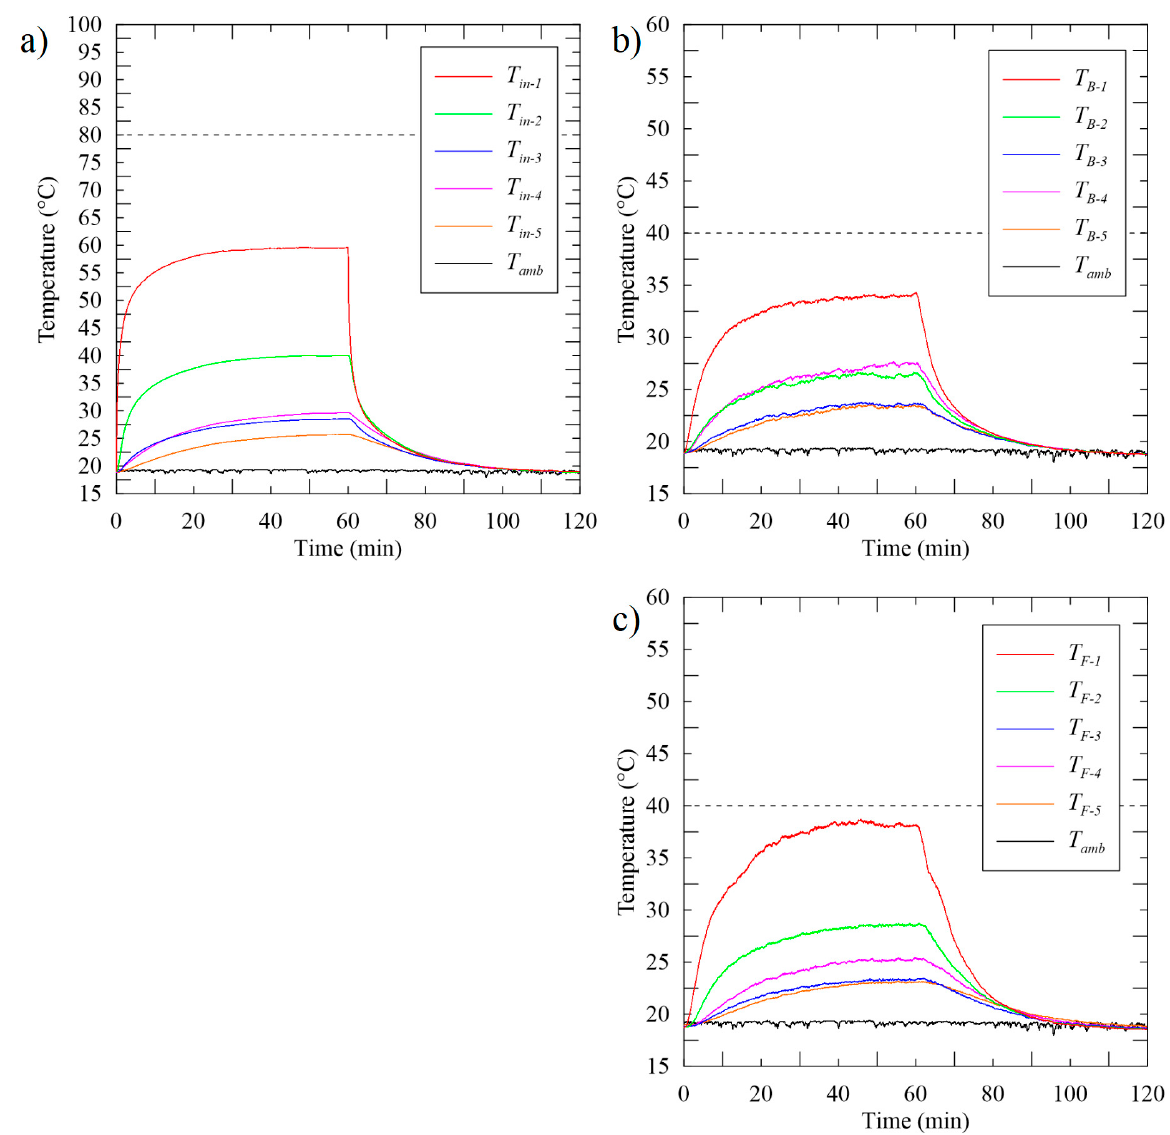
Figure 8. Temperature measurements on the ( a ) inside, ( b ) back cover, and ( c ) display of the mock tablet with an aluminum heat spreader, TIM, and a heat generation rate of 4.5 W (the dashed line represents the relevant temperature limit).